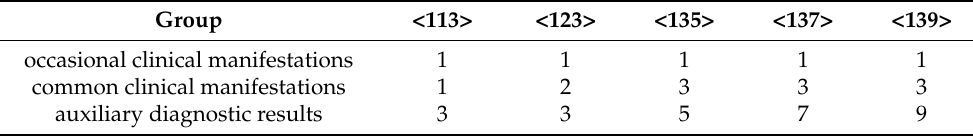
Table 3. Weight setting group of binary-weighted KN.